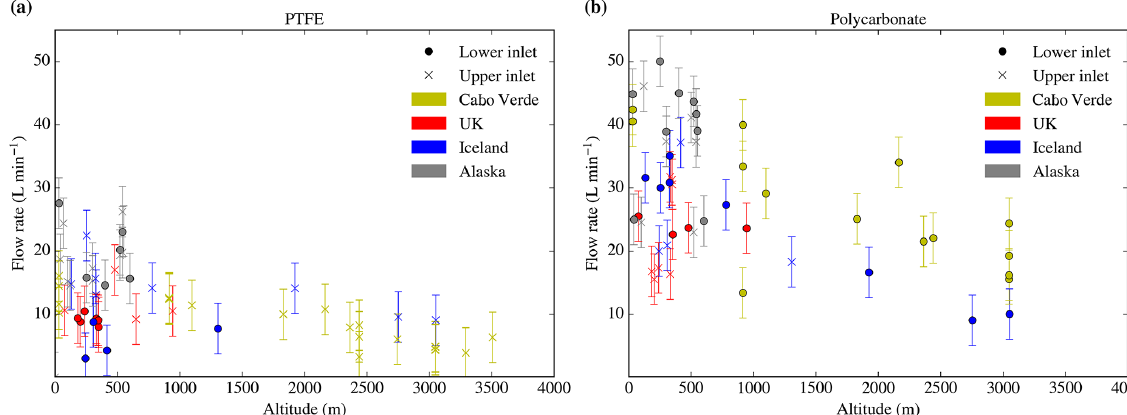
Figure 4. Filter flow rate of different samplings carried out in different campaigns at each altitude using (a) Sartorius PTFE membrane filters (47mm diameter with a pore size of 0.45µm) and (b) Whatman nucleopore polycarbonate track etched filters (47mm diameter with a pore size of 0.4µm). The crosses represent samples taken in the upper line of the inlet system, whereas dots represent the sampling in the bottom line. Different mesh supports were used for the data collection. The data from Cabo Verde were extracted from Price et al. (2018) and the notes of the analysis carried out by the authors, whereas the altitude data from the other three were obtained from the pressure altitude measurement carried out by the reduced vertical separation minimum system on board the aircraft. The altitude data were extracted from the FAAM core datasets C019, C022, C024, C025, C058, C059, C060, C061, C062, C063, C085, C086, C087, C088, C089, C090, and C091 (via the Centre for Environmental Data Analysis). The bypass was closed for all the data in Cabo Verde whereas it was open for all the data in the other campaigns. Note that the flow rate here corresponds to the filter flow rate (measured with the mass flow meter), not the total one.